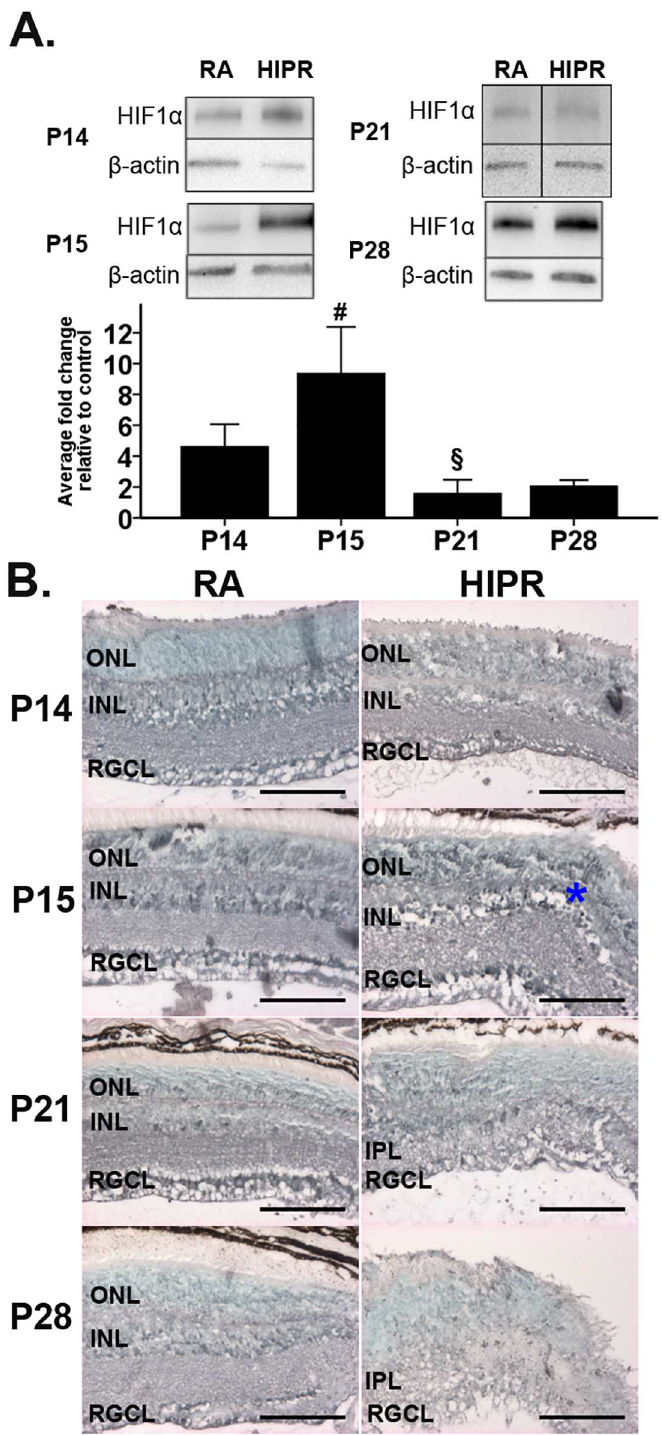
Fig 2. Elevated HIF-1 α levels in hyperoxia-induced proliferative retinopathy. (A) Retinal HIF-1 α was evaluatedby western blotting, quantifiedby densitometry, and normalized to β -actin. Representative blots shown. HIF-1 α levels significantly increasedfrom P14 to P15 and then decreased by P21. Data were fold change ± SEM (n (cid:21) 4 per group). (B) Retinalcross sections were immunostained with HIF-1 α (black, N = 3) and counterstained with methyl green. HIF-1 α was found in the retinal ganglion cell layer and in the